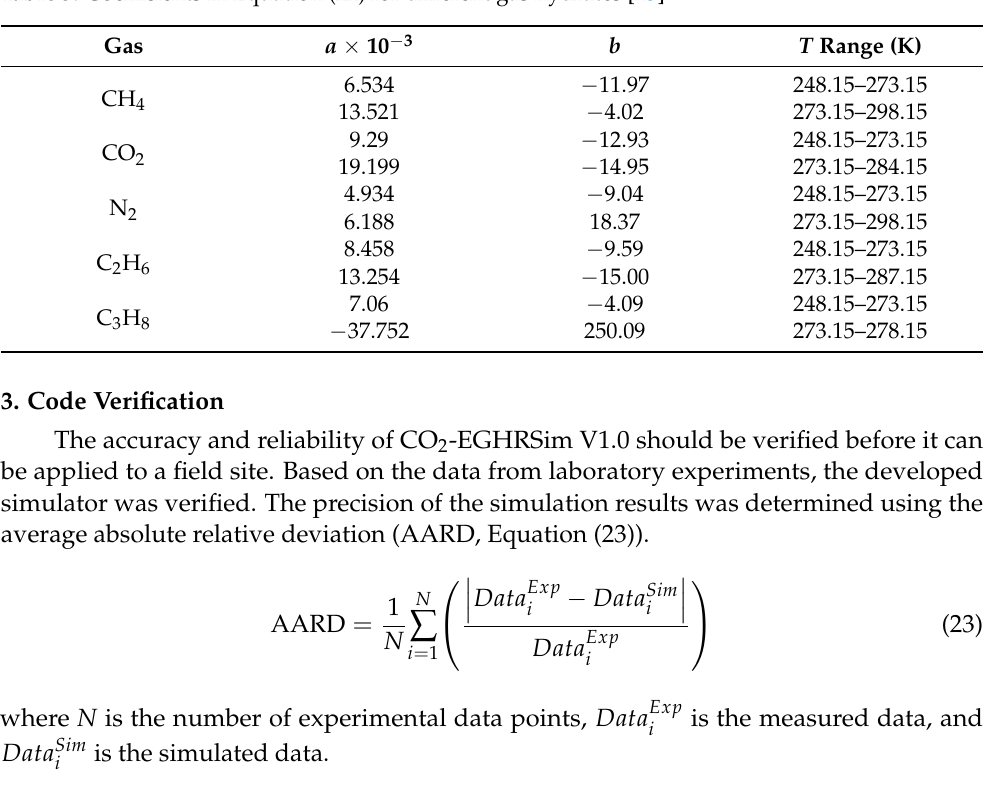
Table 3. Coefficients in Equation (22) for different gas hydrates